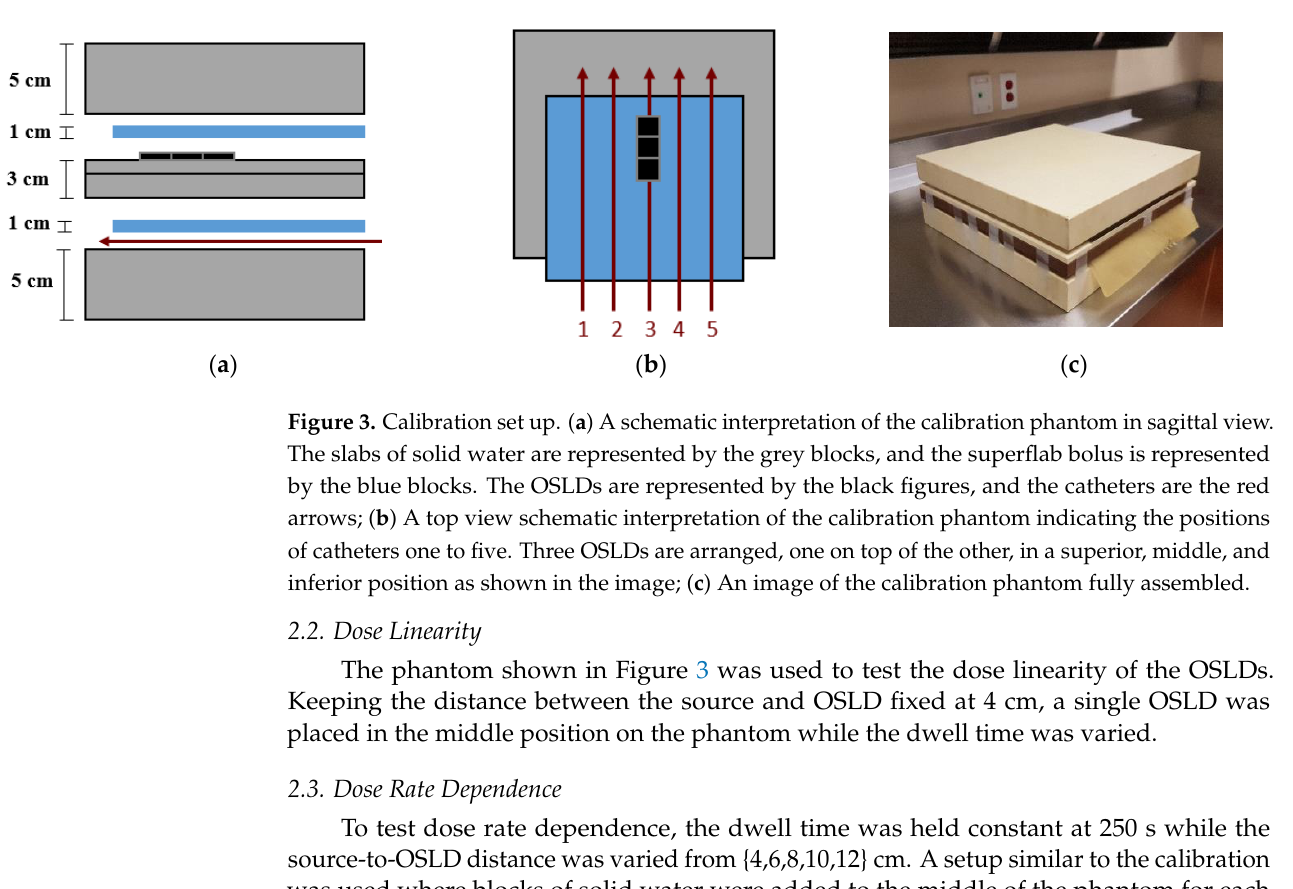
( c ) Figure 5. Angular dependence phantom. ( a ) The phantom used to test OSLD angular dependence. Two 2 cm solid water slabs were used, with the top slab having the machined circle in the center and canal for the catheter as shown in the image; ( b ) A close-up of the top of the angular dependence phantom to show OSLD placement within the superflab bolus as well as the marked angles used for the experiment; ( c ) A depiction of how the OSLD was rotated along its x -axis and y -axis. 2.5. Readout Depletion A group of nine previously irradiated OSLDs were optically annealed and arranged in a 3 × 3 array using the calibration phantom shown in Figure 3. The OSLDs were irradi- ated to a dose in a range from 46 cGy to 52 cGy. Each OSLD was readout 34 times, nor- malizing each set of 34 readings by the average of the first 4 readings of that OSLD to measure the depletion of signal due to multiple readouts. 2.6. Optical Annealing A group of 40 pre-irradiated OSLDs was collected and read to obtain a baseline read- ing. The OSLDs were opened using a paperclip and placed on an X-ray light box from SourceOnce Healthcare Technologies (Model No: FS302FSS1DBWH). The light box used mercury daylight lamps from Sli Lighting (Model No: F15T8 DL) to provide an illumina- tion of 60 Hz, 120 V, and 1.34 A. The OSLDs were placed approximately one centimeter